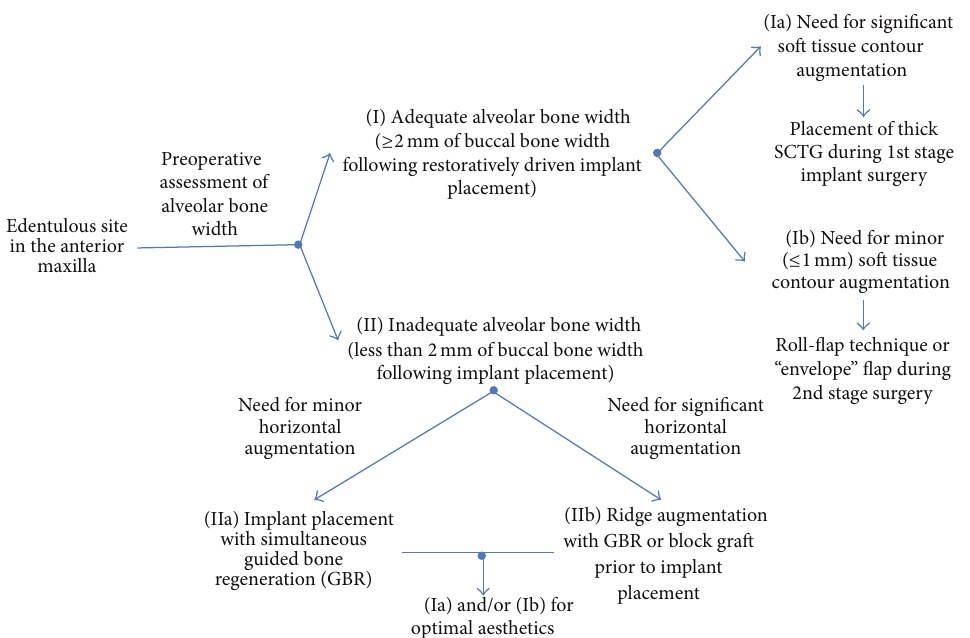
Figure 1: Implants in the anterior maxilla: a clinical decision-tree for overcoming aesthetic